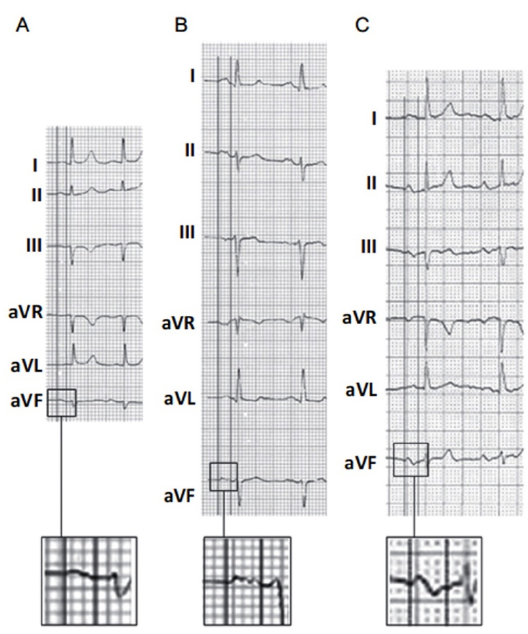
Figure 3. Examples of the 3 types of atrial activity: ( A ) normal P-wave (P-wave duration <120 ms), ( B ) partial interatrial block (P-wave duration ≥120 ms), ( C ) advanced interatrial block (P-wave duration ≥120 ms with biphasic morphology (+/− in leads II, III, and aVF).